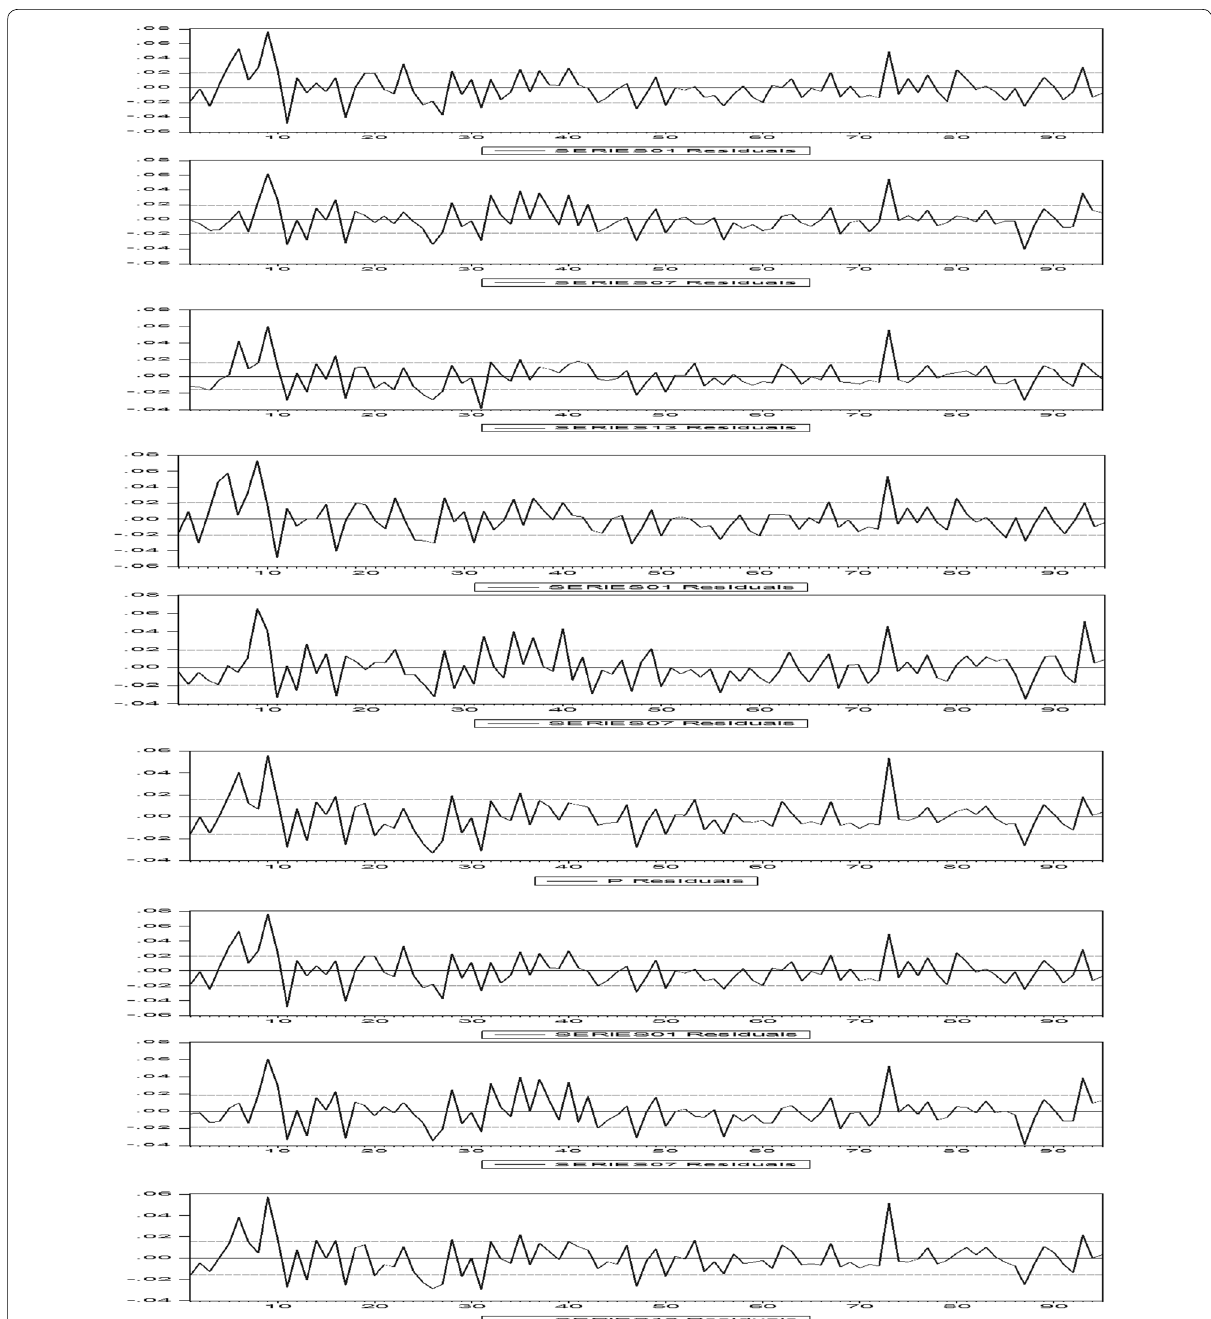
Fig. 2 Residual graphs for Fama–French’s three-factor, three factor with idiosyncratic volatility and four-factor model of first portfolio